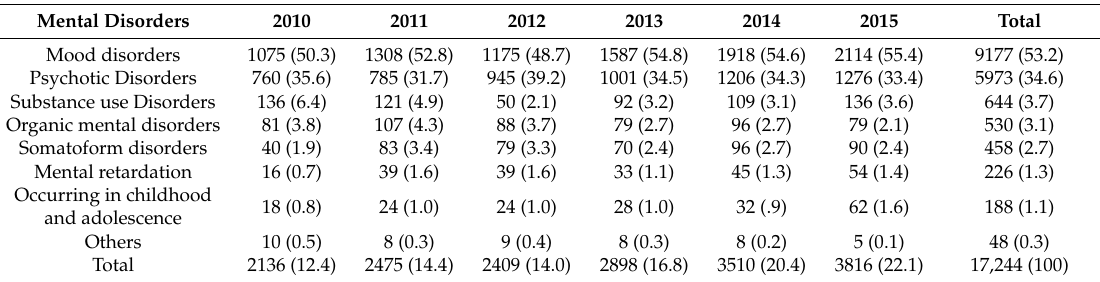
Table 1. The frequency and percentage of inpatients with mental disorders in Beijing Anding Hospital, 2010–2015 (%).